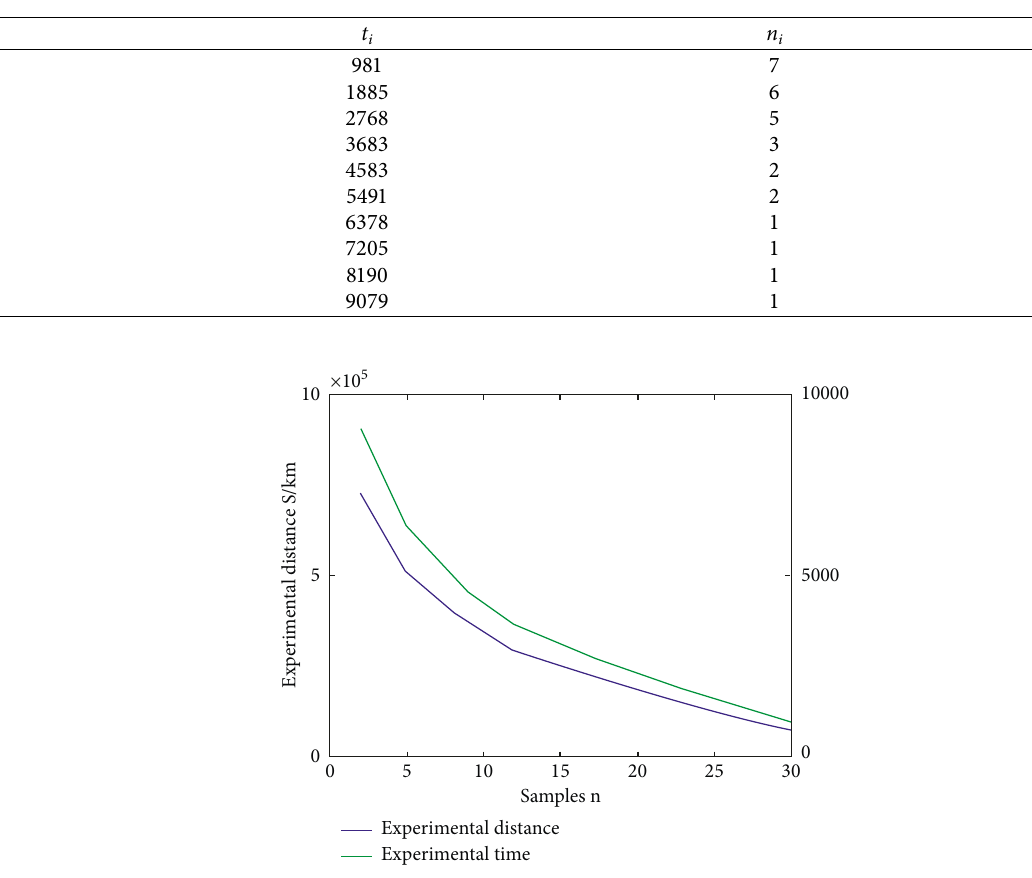
Figure 4: Reliability and failure probability curves of the axle journal bearing for railway wagon. (a) Reliability curves. (b) Failure probability curves. Table 1: Time truncated data.